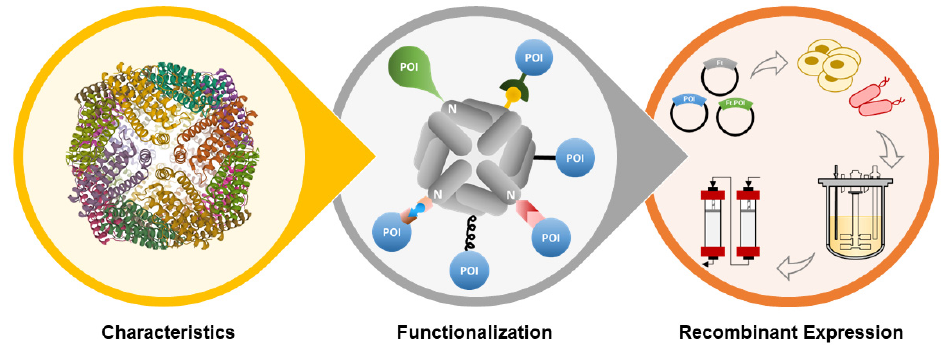
Figure 1. Schematic overview of the topics discussed in this review: ferritin characteristics, functionalization, and recombinant expression of ferritin nanoparticles for antigen-display applications.